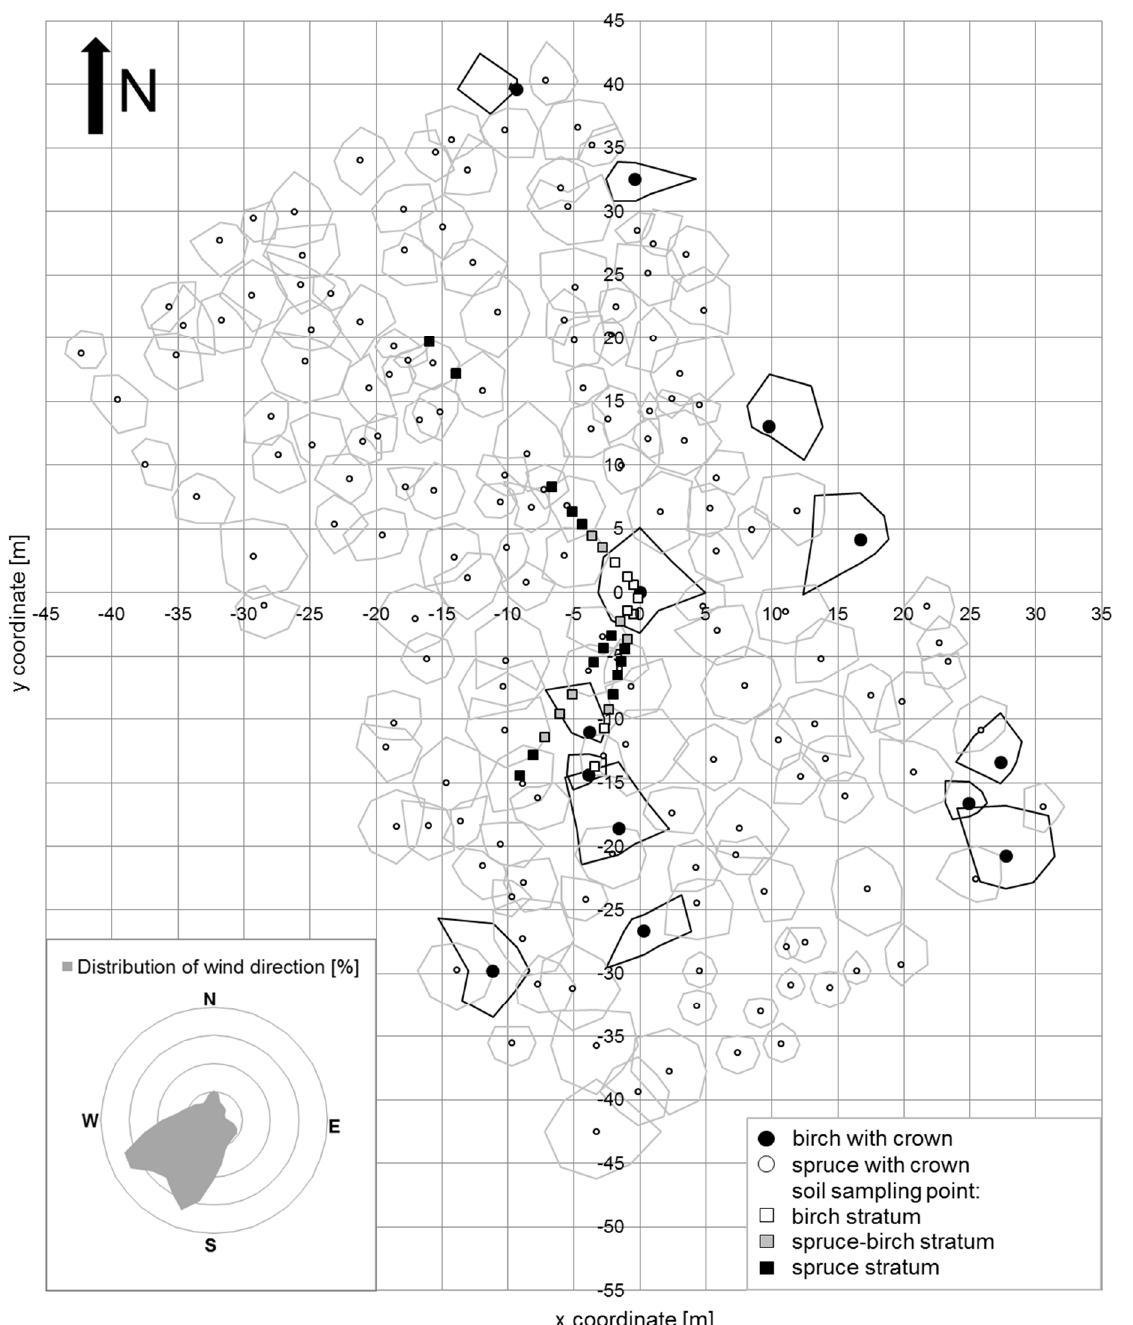
Figure 1. Map of tree stems and crowns with soil sampling points indicated along transects with percental distribution of the wind direction (01.01.1997–31.05.2009) measured at the Olbernhau permanent monitoring area (Staatsbetrieb Sachsenforst); average wind speed: 1.51 m s − 1 , maximum wind speed: 6.41 m s − 1